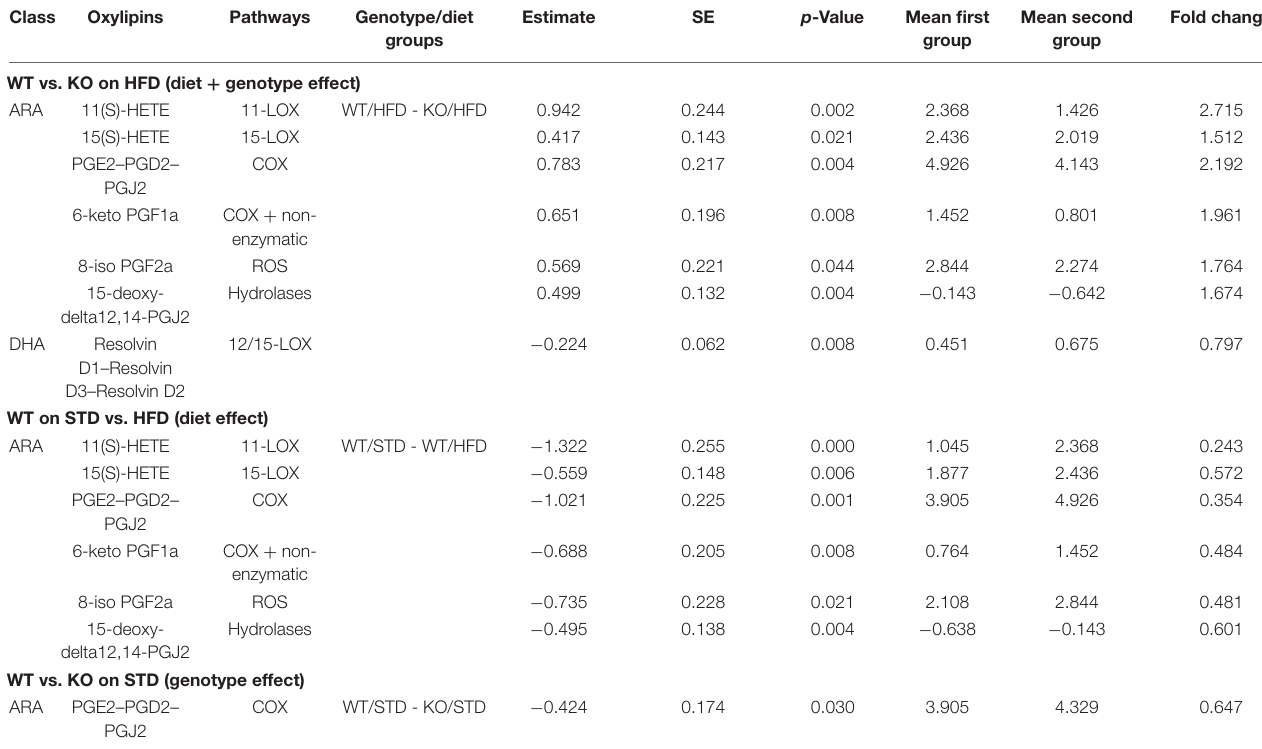
TABLE 2 | Brain oxylipins pathways in GPR39 KO and WT littermate mice fed with standard diet and high fat